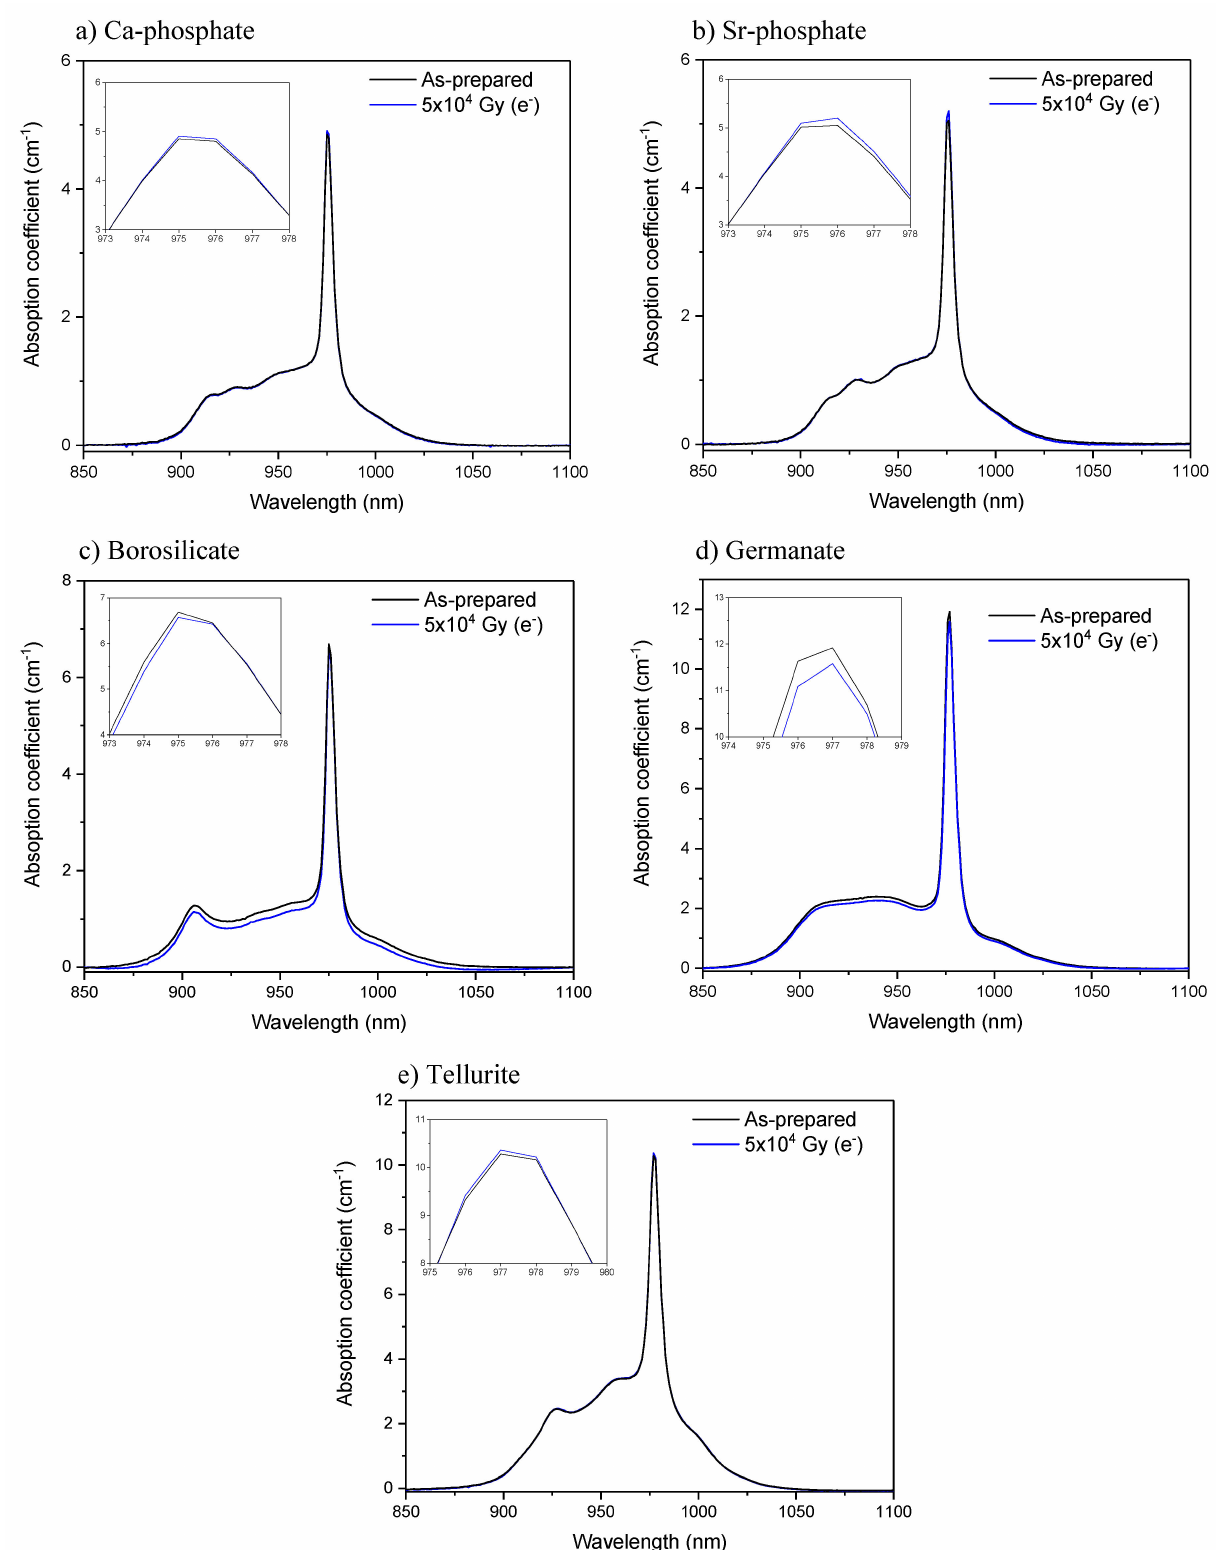
Figure 3. Yb 3+ absorption band of the Ca-phosphate ( a ), Sr-phosphate ( b ), borosilicate ( c ), germanate ( d ) and tellurite ( e ) glasses prior to and after radiation treatment. Inset figures show the absorption coefficient around the peak